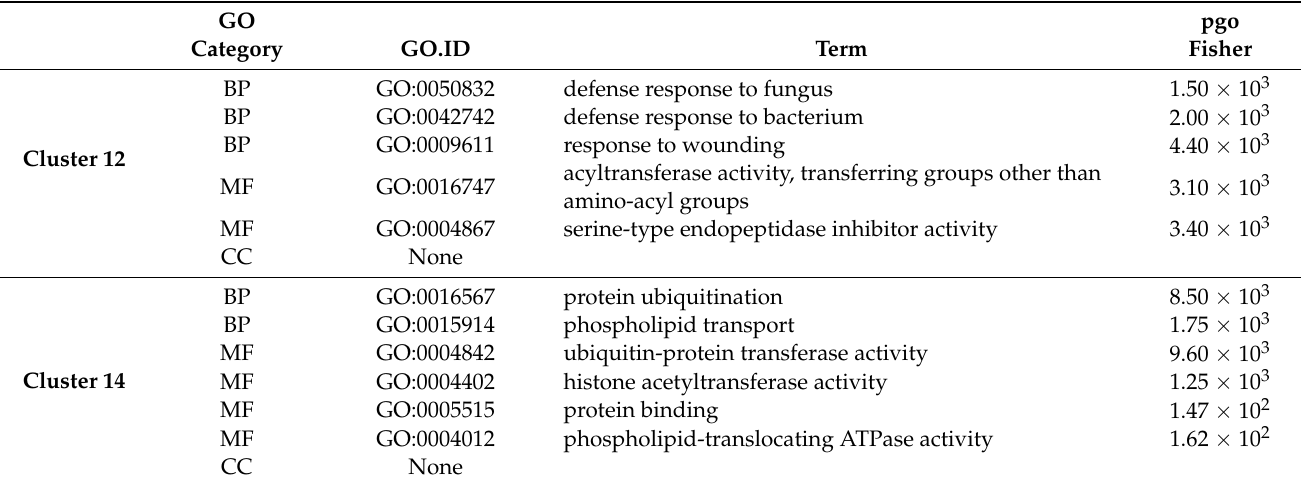
Table 1. Gene ontology (GO) analysis ( p ≤ 0.05) of the biological (BP) and molecular function (MF) processes, and of the cell components (CC), corresponding to the DEGs ( p ≤ 0.05) belonging to clusters 12 and